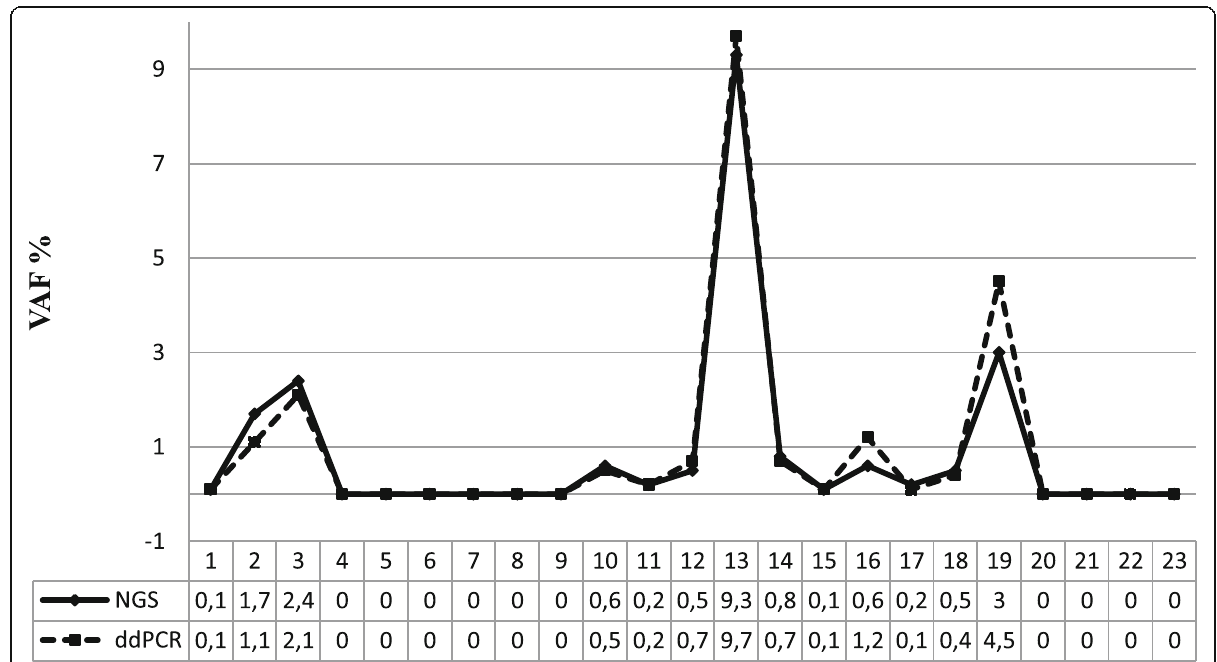
Fig. 3 T790M detection comparison between tag-based NGS and ddPCR. Variant Allele Frequencies detected by tag-based NGS (black line) and ddPCR (dashed line) for 23 plasma samples are shown. NGS, tag-based NGS; ddPCR, droplet digital polymerase chain reaction; VAF, Variant Allele